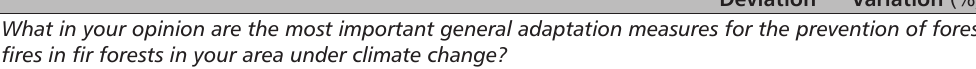
TABLE 3. Perspectives of climate change and fire prevention to fir forests Perception